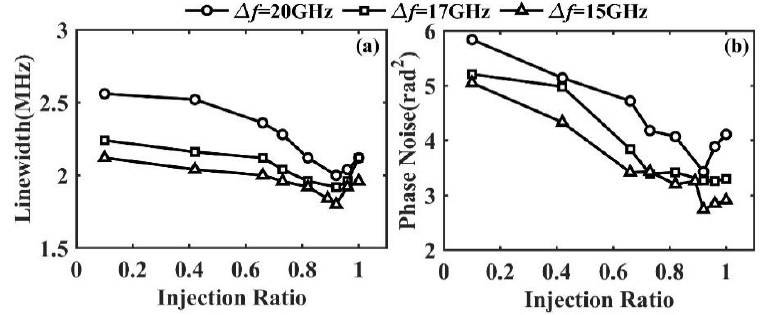
Figure 5. ( a ) Linewidth and ( b ) phase noise of the generated microwave versus ξ inj .